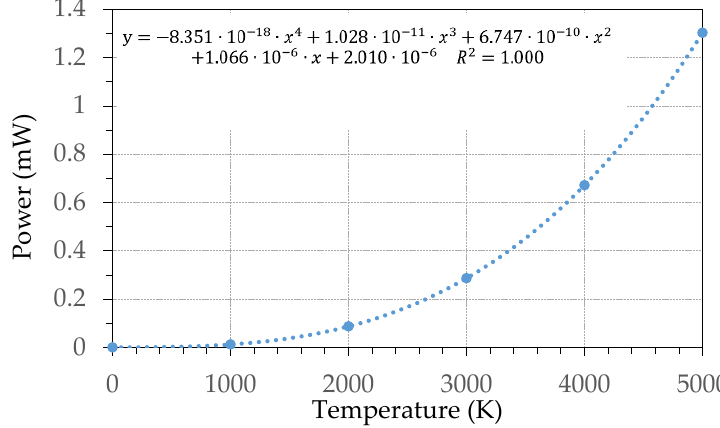
Figure 10. Simulation of working temperatures for different heating power.